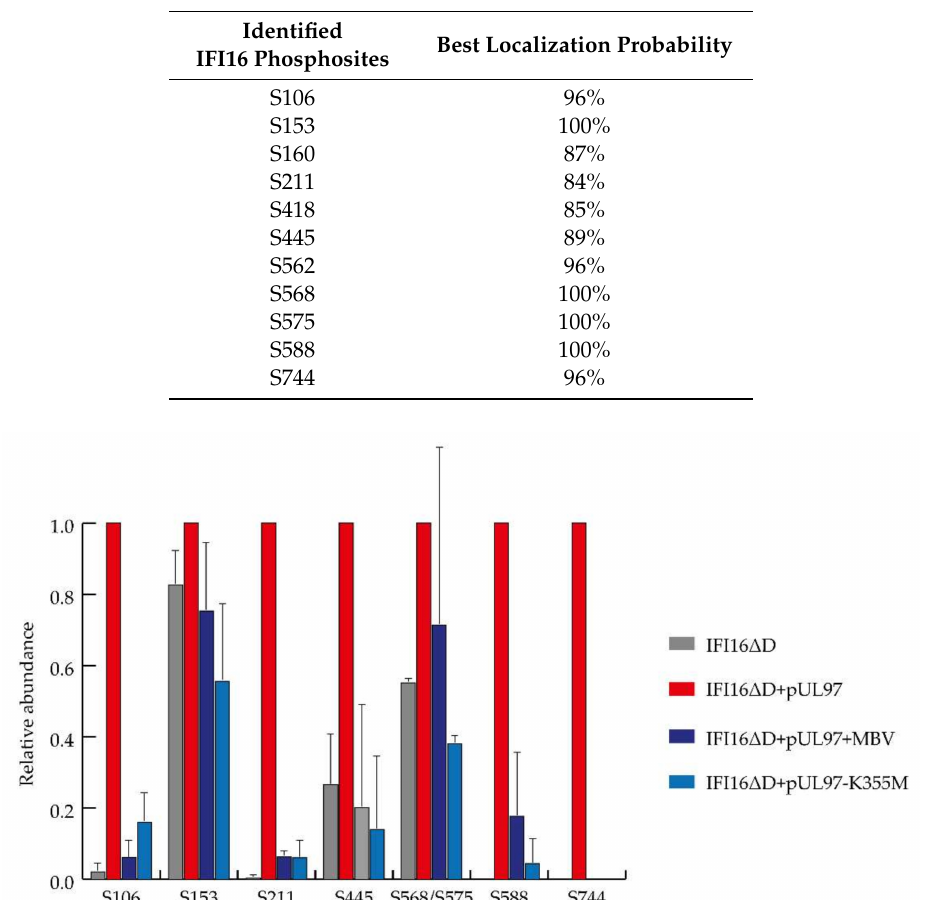
Table 1. Identification of IFI16 phosphosites by MS-based phosphoproteomic analysis. Only sites identified with a localization probability above 75% were considered.